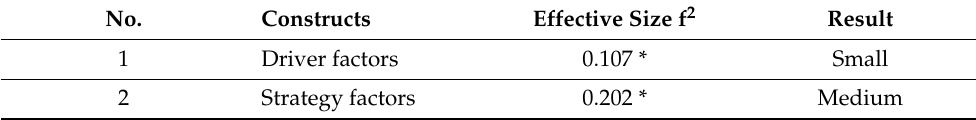
Table 9. Assessment of effect size (f 2 ).